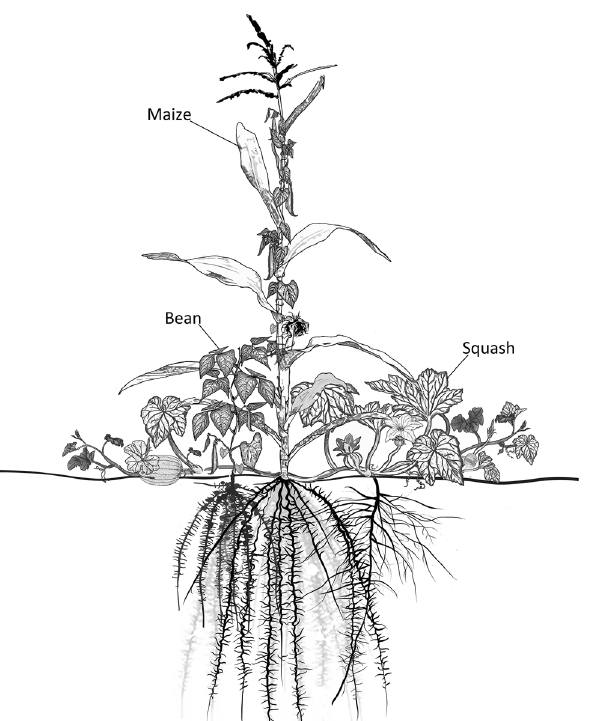
Figure 1. The classic milpa with